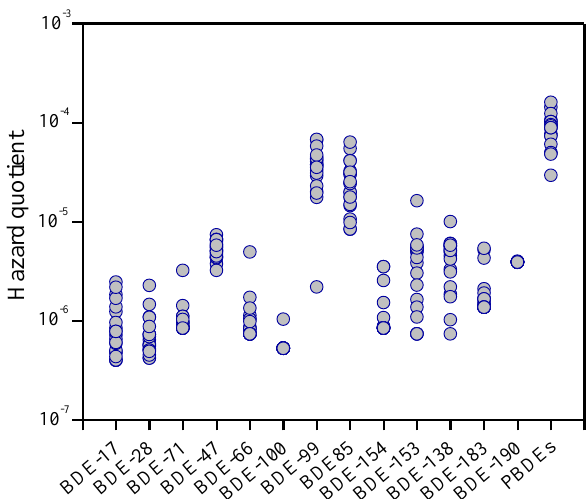
Figure 7. Hazard quotient (HQ) for particulate PBDEs in the atmo- sphere of Shanghai. PBDEs are the sum of BDE-17, 28, 71, 47, 66, 100, 99, 85, 154, 153, 138, 183, and 190.